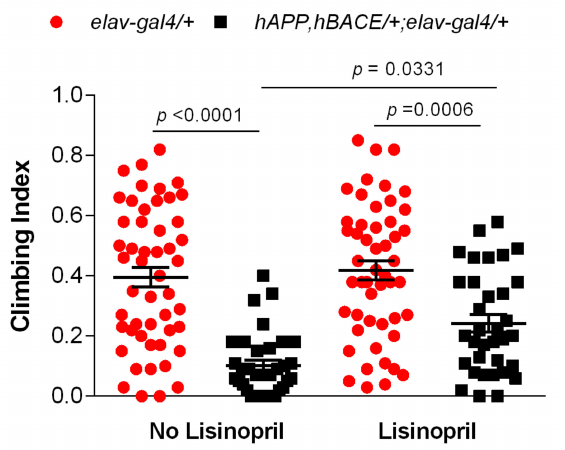
Figure 2. Lisinopril treatment improves climbing ability in AD flies. On average, untreated hAPP , hBACE / + ; elav-gal4 / + AD flies traveled significantly less than matched controls. However, while climbing is not affected by the ACEi treatment in controls, lisinopril-fed AD flies traveled significantly more than untreated AD flies. Error bars represent the S.E.M. p -values obtained from Tukey–Kramer post hoc tests for multiple